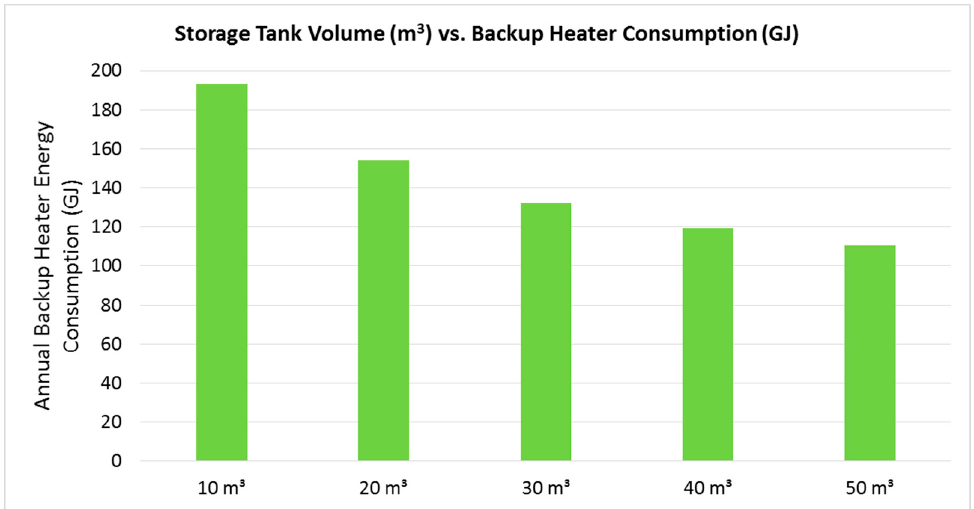
Figure 8. The impact of storage tank volume on backup heater energy consumption.